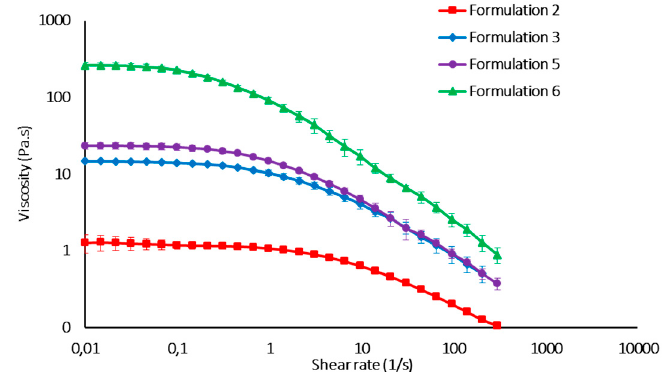
Figure 1. Flow curves of some HA formulations of the experimental design (mean values ± s.d., n = 3).